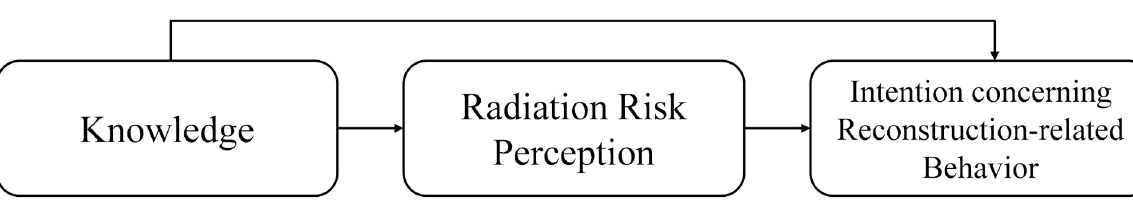
Fig 1. Hypothetic model of reconstruction-related behavior.